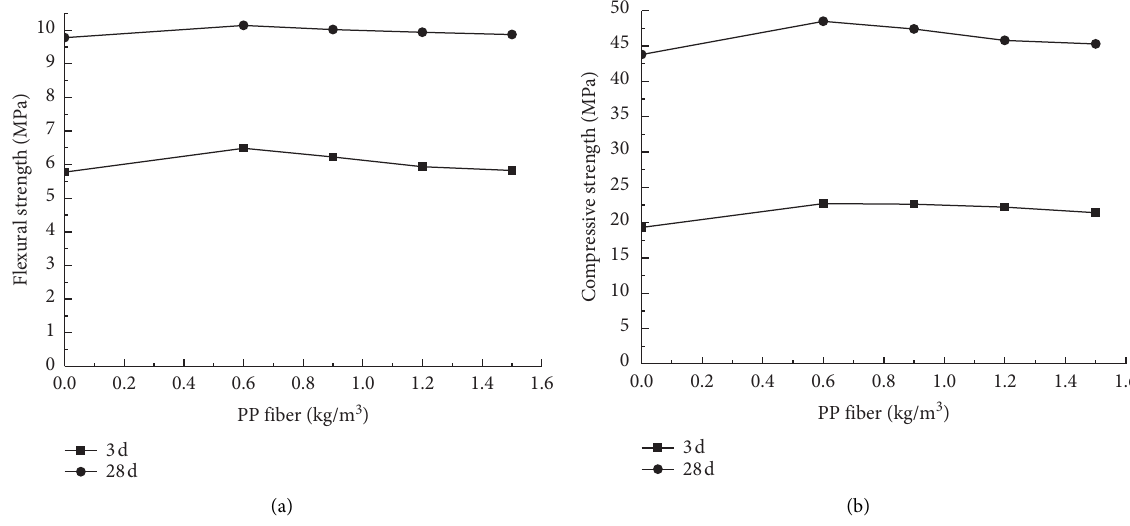
Figure 2: Effect of PP fiber on the strength of CGA mortar. (a) Flexural strength. (b) Compressive strength.